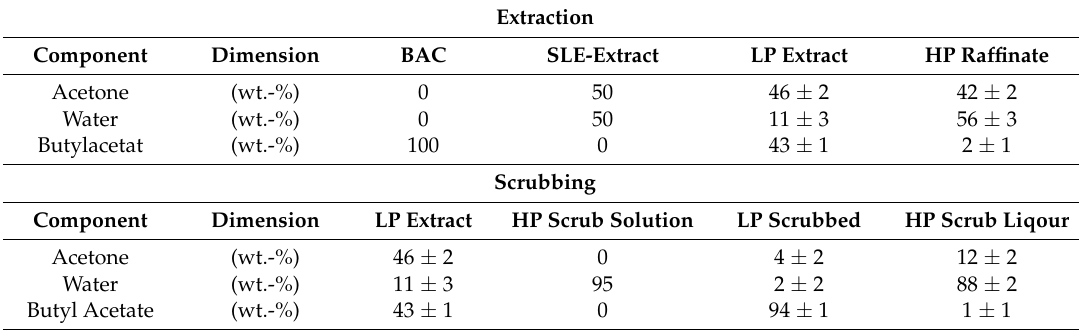
Table 3. Composition of LP (light phase) and HP (heavy phase) according to Fourier-transform infrared (FTIR) after extraction and scrubbing (second operating point). Composition for BAC (butyl acetate), SLE (solid-liquid extraction) extract and HP scrub solution are based on the weighed in